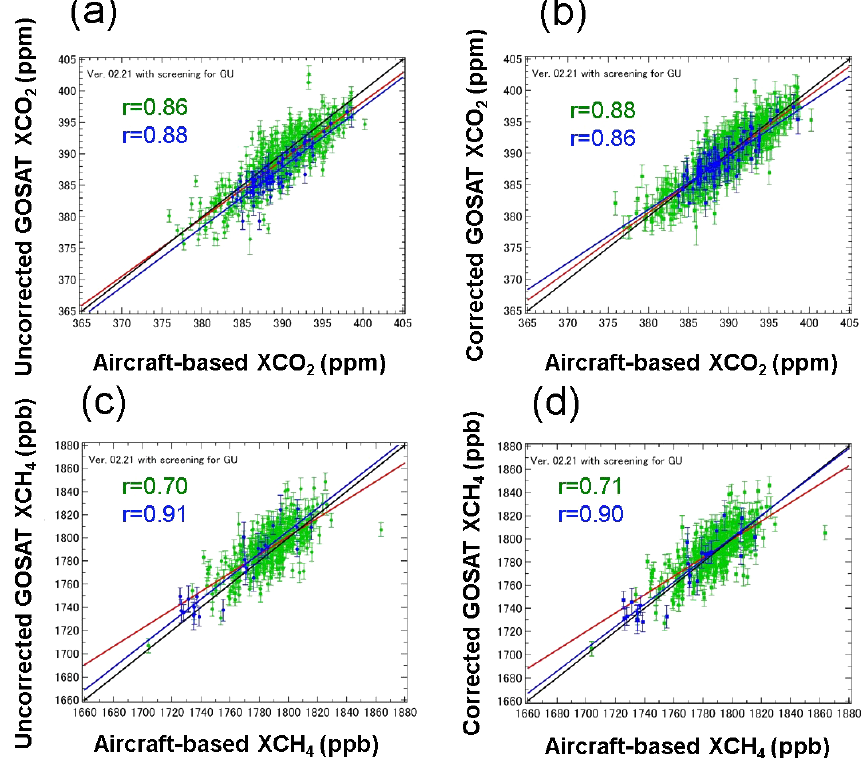
Figure 5. Scatter diagrams between (a) uncorrected and (b) corrected GOSAT XCO 2 observed within ± 5 ◦ latitude/longitude boxes (centered on each aircraft profile) and aircraft-based XCO 2 observed on the same day. (c, d) , same as (a) and (b) for XCH 4 . Green and blue dots indicate the GOSAT data obtained over land and ocean regions, respectively. Red and blue lines denote the regression lines, statistically significant at the 99% level, over land and ocean regions, respectively. Black lines show the one-to-one